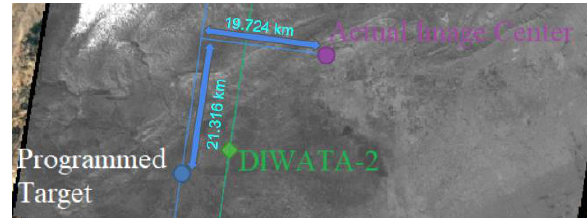
Figure 9. Manila, Philippines. Distance from programmed target to actual image center.